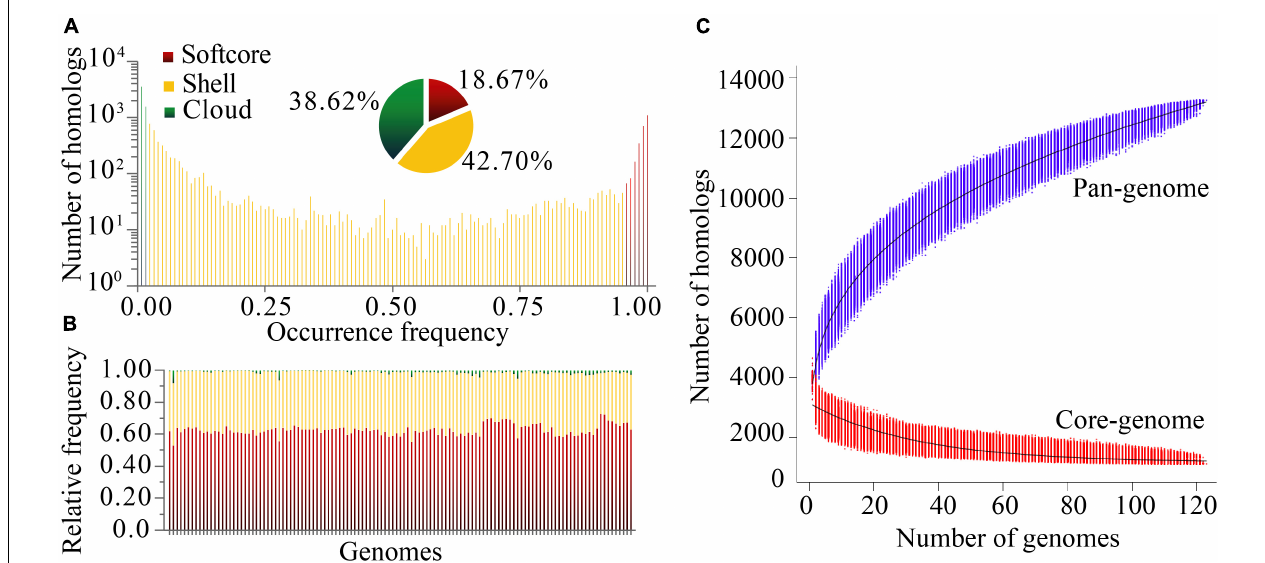
FIGURE 3 | Homologous gene cluster based pan-genome. (A) Composition of the P. stutzeri pan-genome. (B) Relative frequency of softcore, shell and cloud pan-genes for individual genomes; on the X-axis, each vertical bar represented one genome. (C) Simulations of the increase of pan-genome size and decrease of core-genome size. Genomes were sampled as 20,000 random combinations of each given number of genomes. Solid black lines indicate pan- and core-genome curves fitted using points from all random combinations according to the models implemented in PGAP software.